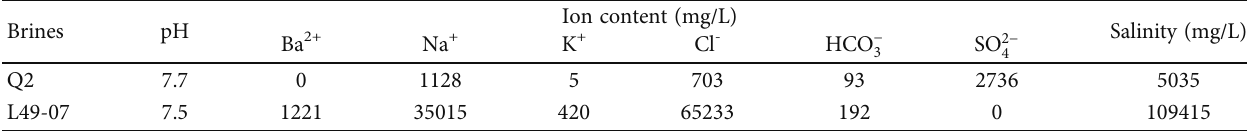
Table 2: Ionic composition of synthetic formation and injection